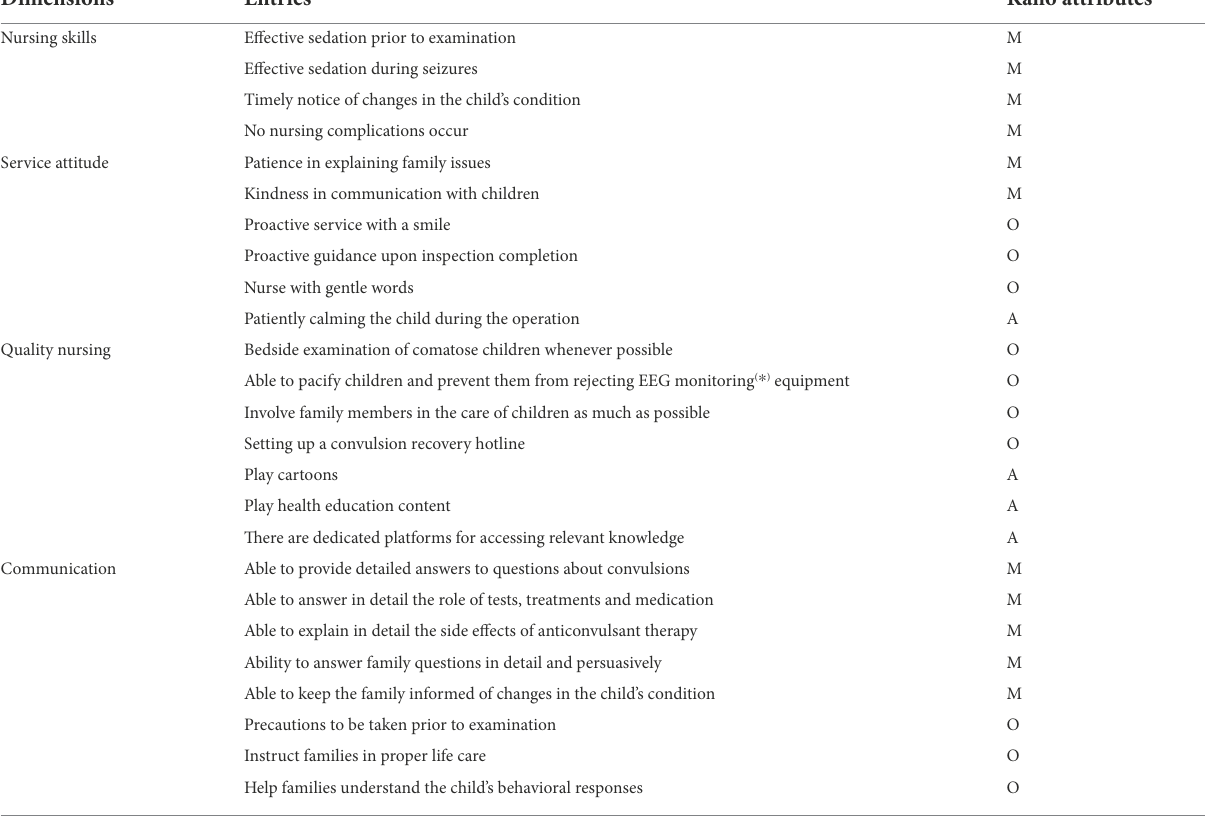
TABLE 3 Survey results on the attributes of the caring care service needs of the families of FS children.